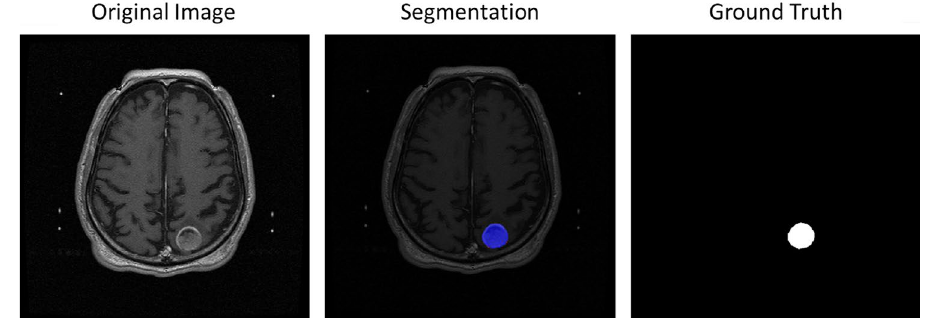
Figure 6. Selected the tumor segmentation results compared in